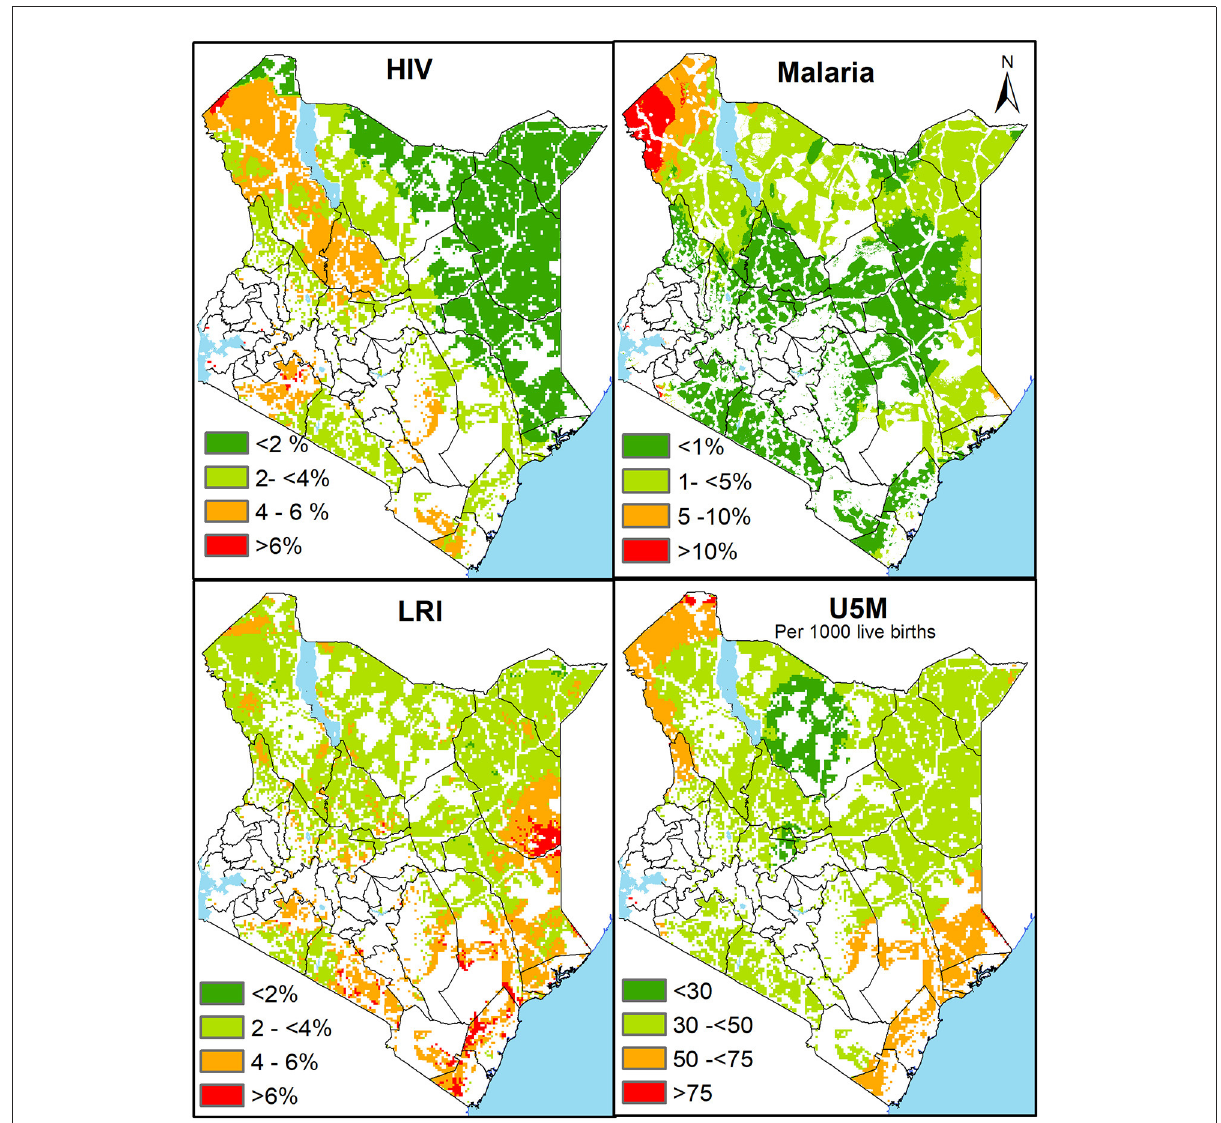
FIGURE4 The spatial variation of infection prevalence of HIV, Malaria, LRI and under five mortality in areas outside 1-h catchment of the nearest health facility (public and private) in 2021. Red represents areas of dual burden with high disease prevalence or mortality and over 1-h distance from health facility while green shades represent regions of lower disease prevalence or mortality outside